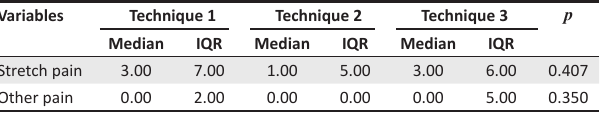
VAS, visual analogue scale – Friedman test.